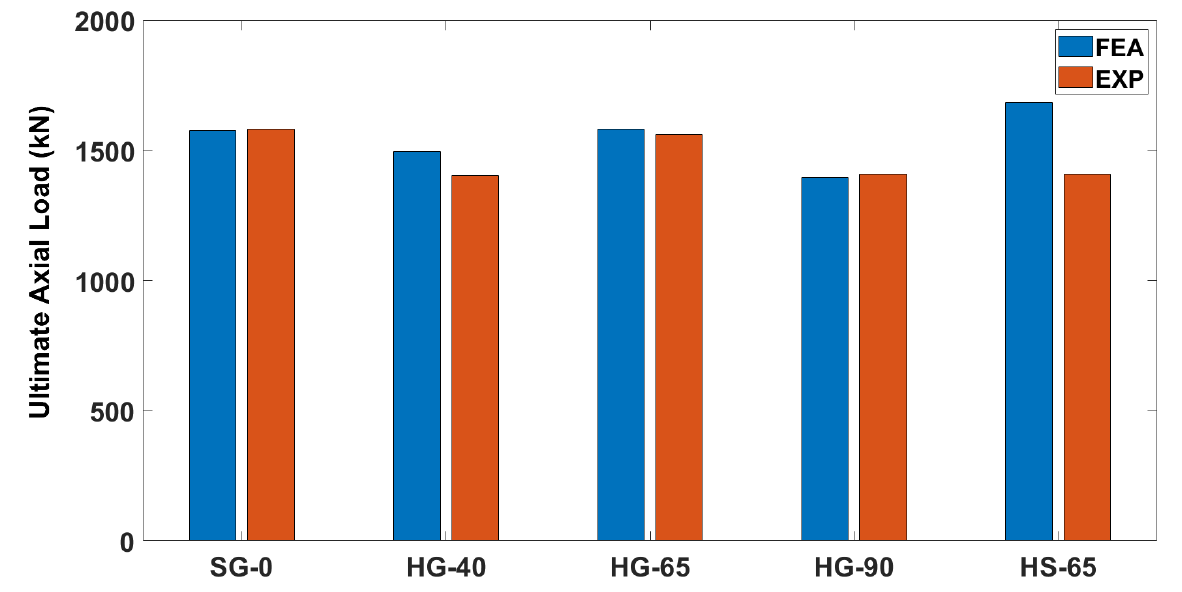
Figure 14. Ultimate axial load-carrying capacities.